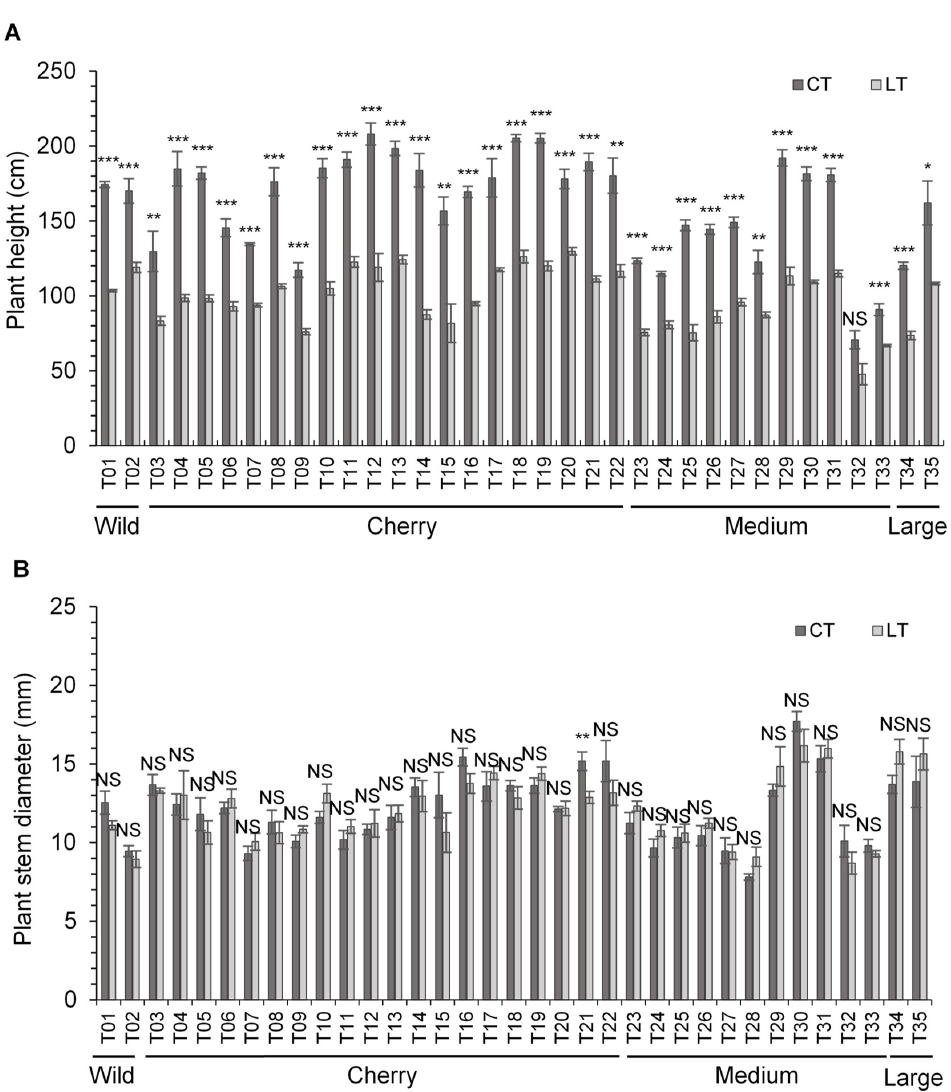
Figure 1. The analysis of vegetative traits on ( A ) plant height and ( B ) plant stem diameter among 35 tomato accessions with different fruit types under CT and LT greenhouses. Plant height and stem diameter were measured at 70 days after transplanting. Significant differences were evaluated with Student’s t -test ( p ≤ 0.05, p ≤ 0.01, and p ≤ 0.001) and are denoted by *, **, and ***, respectively. NS indicates not significant and bars indicate ± standard deviation ( n = 5).